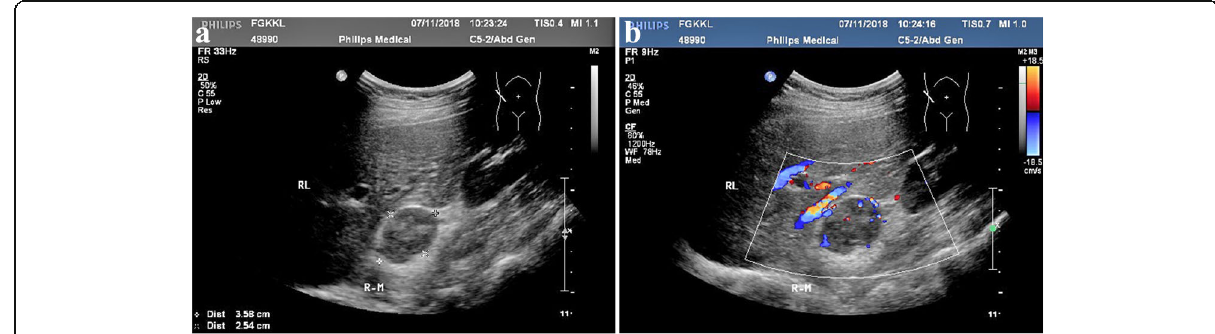
Fig. 2 Ultrasound image showing a hypoechoic mass with a clear boundary in the right adrenal gland. The internal echo is heterogeneous ( a ). Color Doppler flow image showing a rich blood flow signal inside this mass ( b